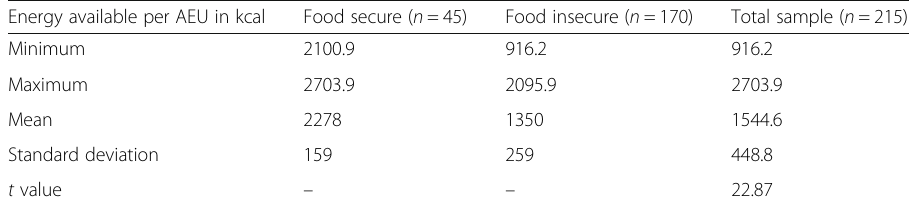
Table 1 Energy available per AEU per day among sample households Energy available per AEU in kcal